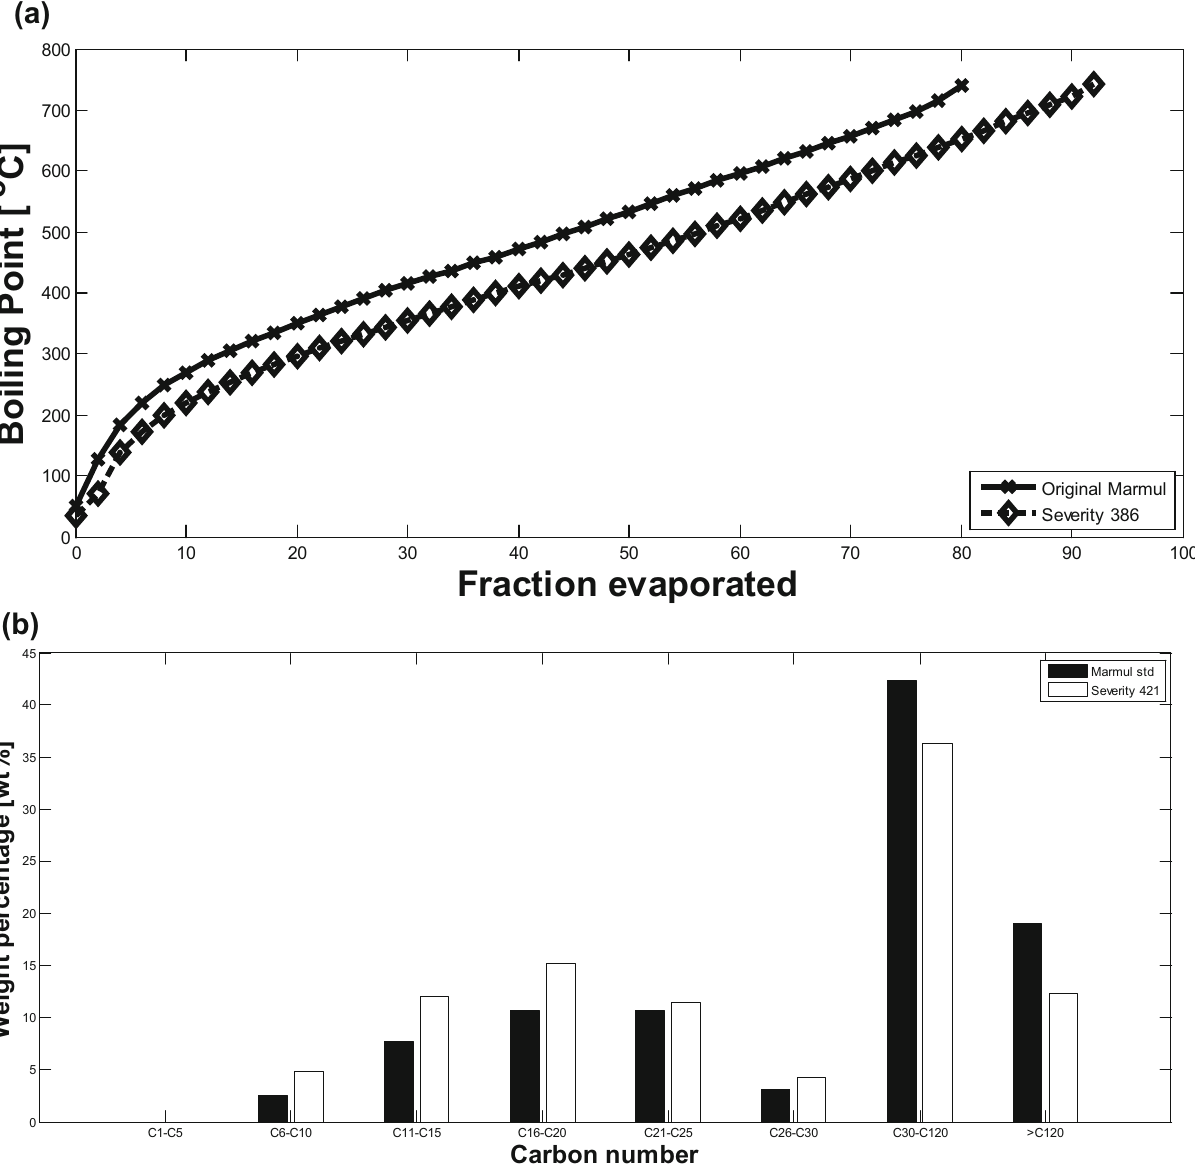
Fig. 4 Lightening of heavy oil by subcritical water processing. ( a ) Boiling point curves for original and processed sample. ( b ) Mass distribution as function of carbon